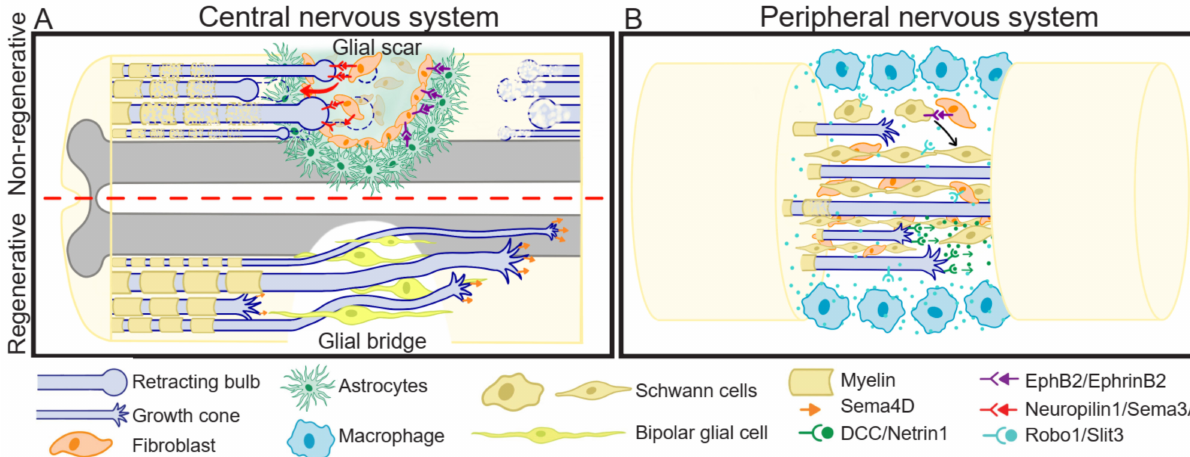
Figure 2. Guidance cues are associated with the glial scar and glial bridge. ( A ). Schematic representation of non-regenerative (NR) and regenerative (R) spinal cord response after injury. Injured axons from NR animal models (upper panel) fail to form a growth cone but instead form a retracting bulb guiding axonal degeneration, while a glial scar is formed in the injury site, which expresses mainly repulsive guidance cues. Injured axons from R animal models (lower panel) generate a growth cone, which travels through the ablation gap following a glial bridge formed by bipolar glial cells, that also expresses guidance cues. ( B ). Schematic representation of a peripheral nervous system axon after injury. Damaged axons can regenerate by extending through the ablation gap, following a glial bridge formed by Schwann cells and macrophages, which express different guidance cues that restrict a corridor for axons to